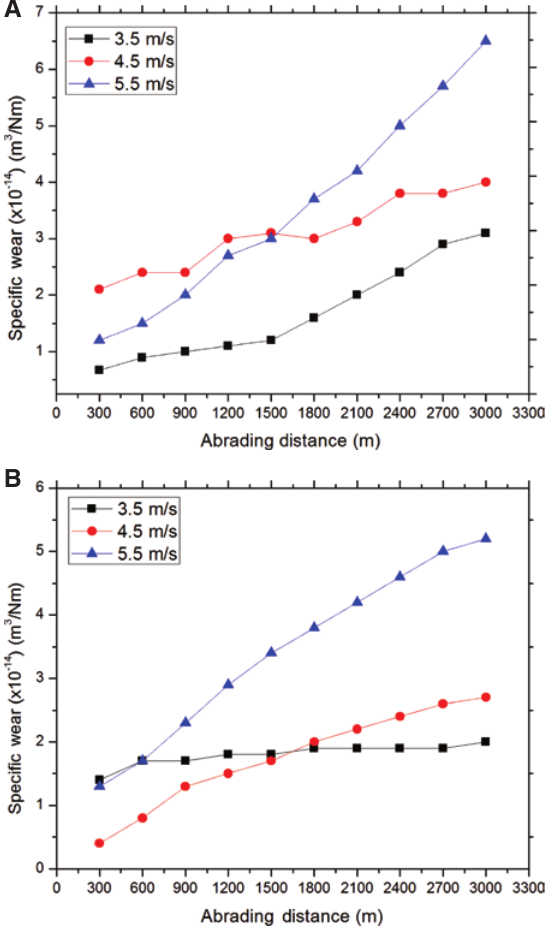
Figure 5 Effect of sliding velocity on specific wear, run at 10 N load: untreated composites (A) and alkali-treated composites